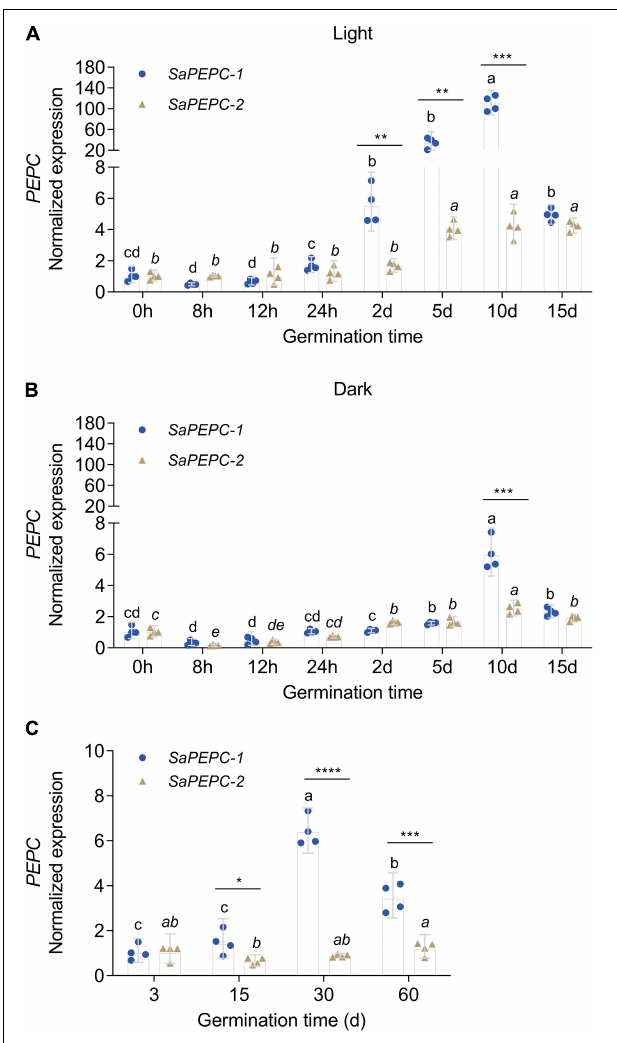
FIGURE 6 | Relative expression of two SaPEPC genes in seed germination and the seedling growth of S. aralocaspica . (A,B) Seed germination under light or in the dark; (C) Seedling growth under light. Different lowercase letters indicate a significant difference of the same gene at different time points; *, **, ***, ****: Indicate a significant difference between SaPEPC-1 and SaPEPC-2 at the same time point at 0.05, 0.01, 0.001, 0.0001 level, respectively. Values are geometric mean ± 95% CI of four biological